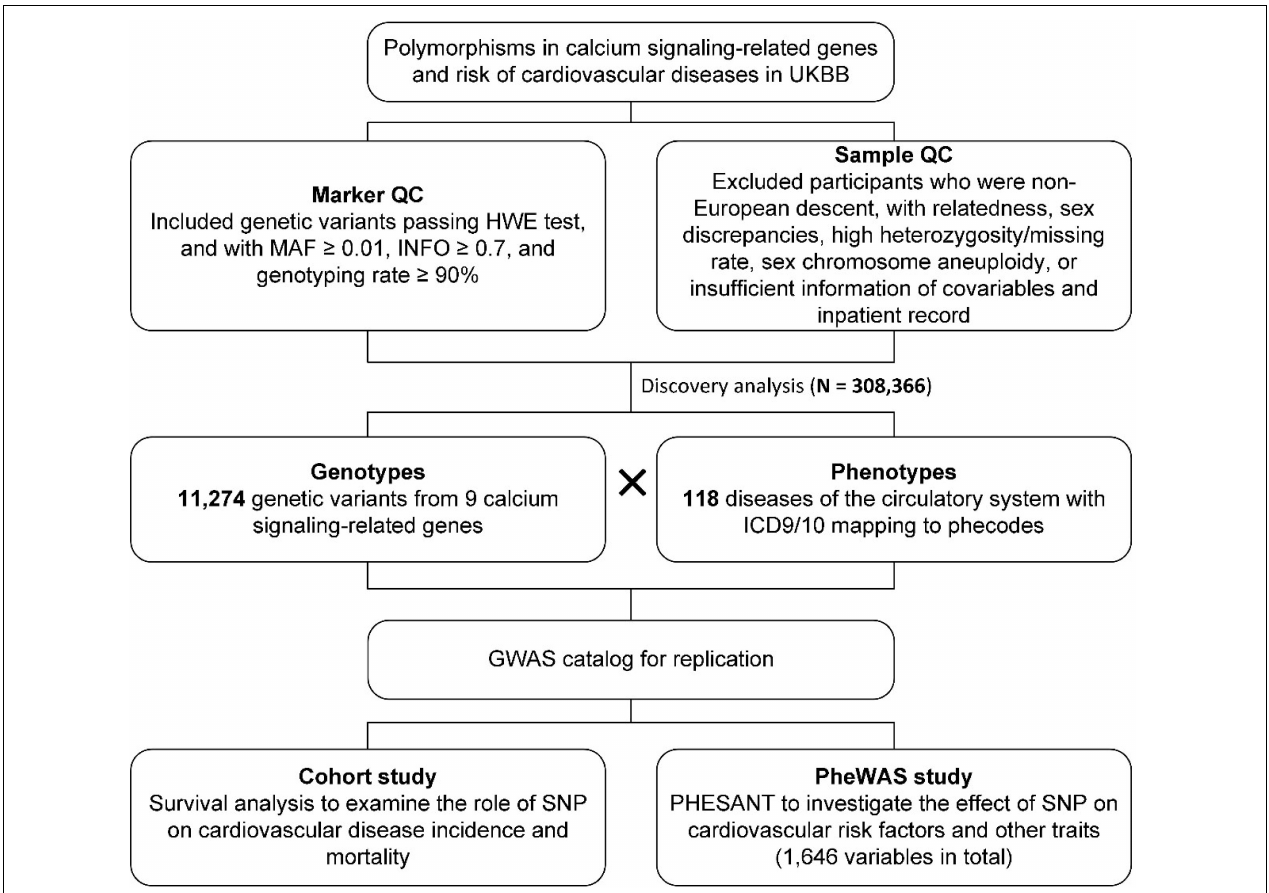
FIGURE 1 | Workflow diagram for discovery and validation of associations between genetic variants in calcium signaling-related genes and CVDs.